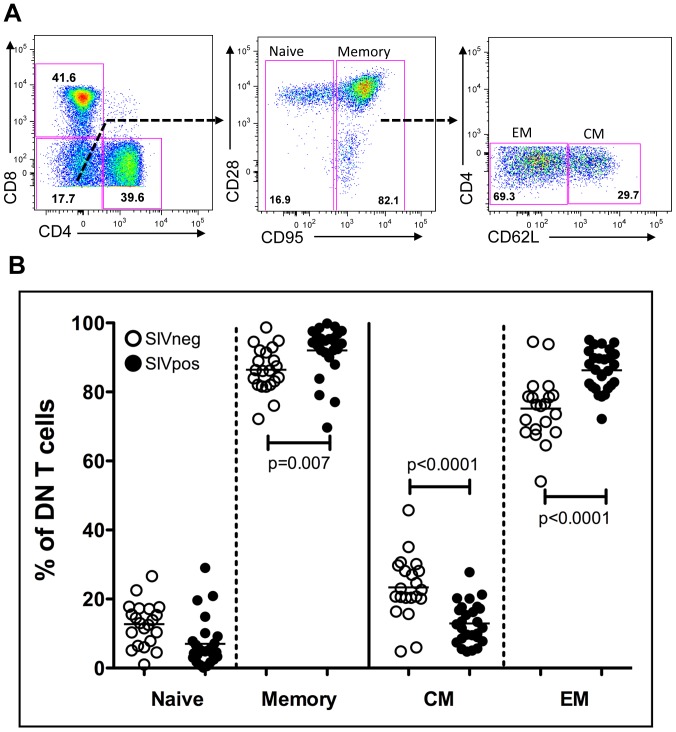
Double negative (CD3+CD4−CD8−) T cells from sooty mangabeys are predominantly effector memory cells.(A) Phenotypic assessment of T cell subsets (CD3+) depicting DN T cells (CD4−CD8− in the lower left quadrant) in sooty mangabey PBMC. Further assessment of naïve (CD95−) and memory DN subsets were performed based on CD95 and CD28 expression. Characterization of central memory (CM: CD95+CD62L+) and effector memory (EM: CD95+CD62L−) DN T cells are depicted. (B) DN T cells from uninfected mangabeys (open symbols) and SIV-infected mangabeys (filled symbols) were evaluated as Naïve, memory, CM and EM subsets and the relative percentage of each is depicted. DN T cells in the PBMCs are primarily memory cells (CD95+) with a predominant effector memory phenotype.